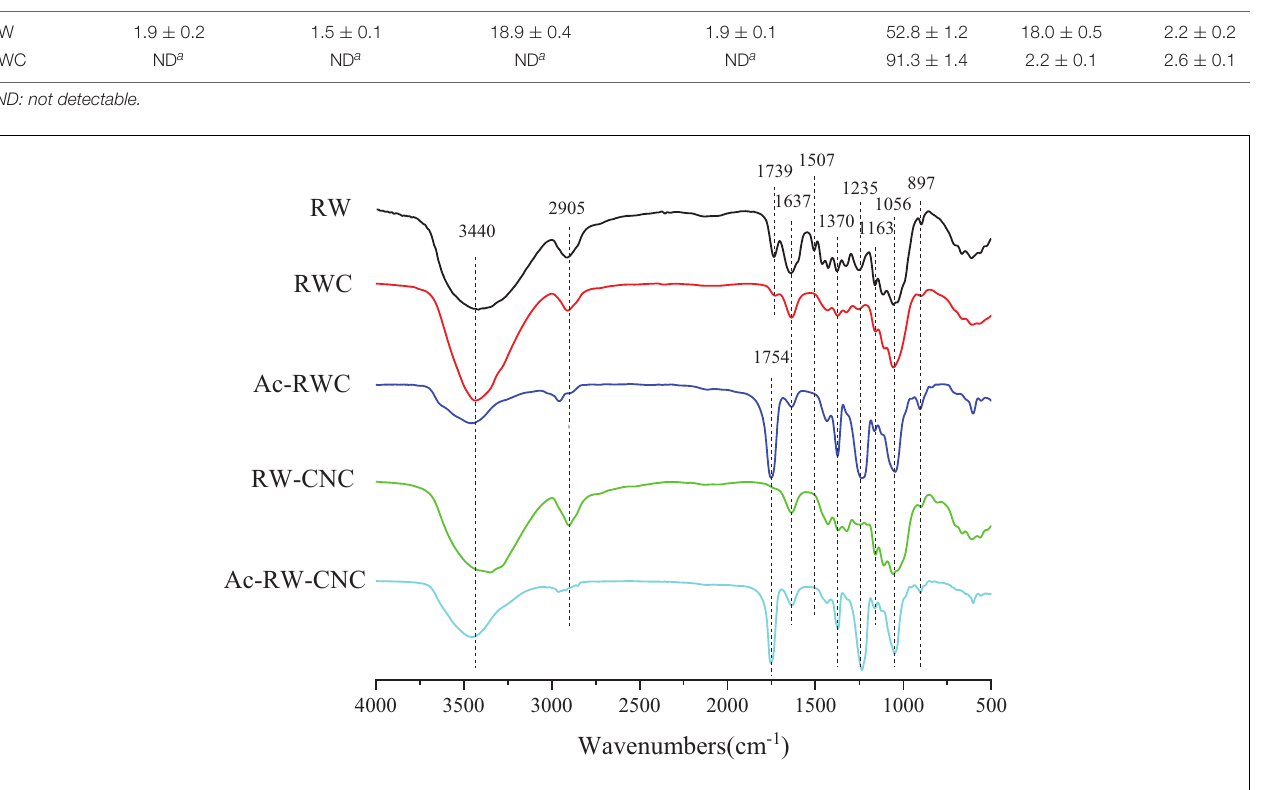
TABLE 1 | Chemical composition analysis of RW and purified RWC. Samples